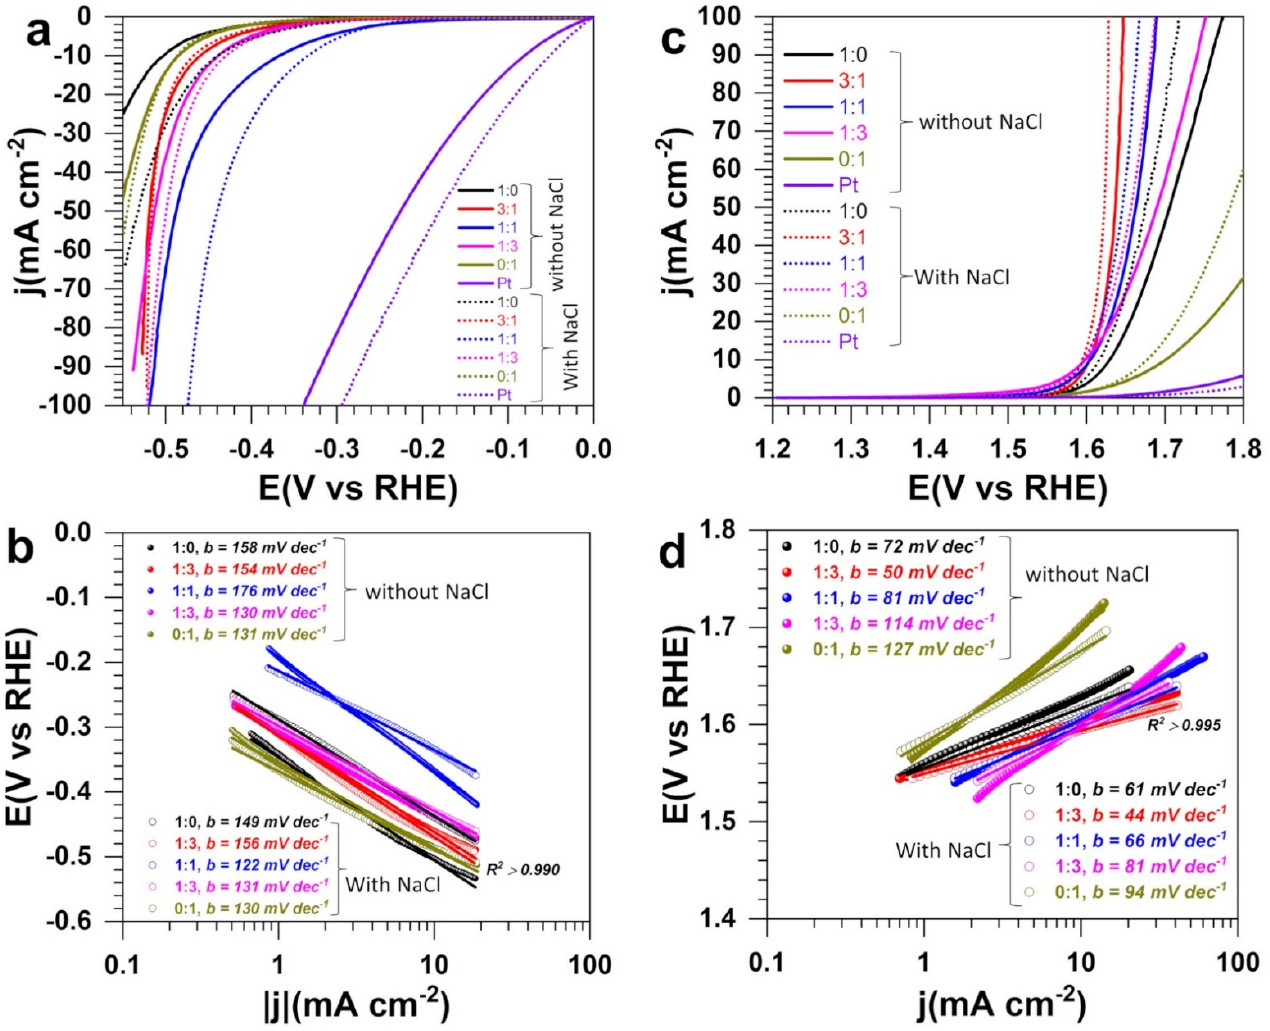
Figure 6. Three-electrode experiments: Polarization curves at room temperature using the as-fabricated electrocatalysts (both at anode and cathode) for PANI-Ni:PANI-Co ratios of 1:0, 3:1, 1:1, 1:3, and 0:1 based on atomic ratio of Ni:Co after calcination. ( a ) HER at 0.005 V s − 1 in 1 M NaOH in the absence (solid) and presence (dotted) of 1 M NaCl. ( b ) Tafel plots for HER. ( c ) OER at 0.005 V s − 1 in 1 M NaOH in the absence (solid) and presence (dotted) of 1 M NaCl. ( d ) Tafel plots for OER. Pt refers to commercial electrocatalyst Pt/Vulcan. The support (blank) was a carbon paper electrode of 2 cm high and 2 cm wide—i.e., 8 cm 2 for both external surfaces.